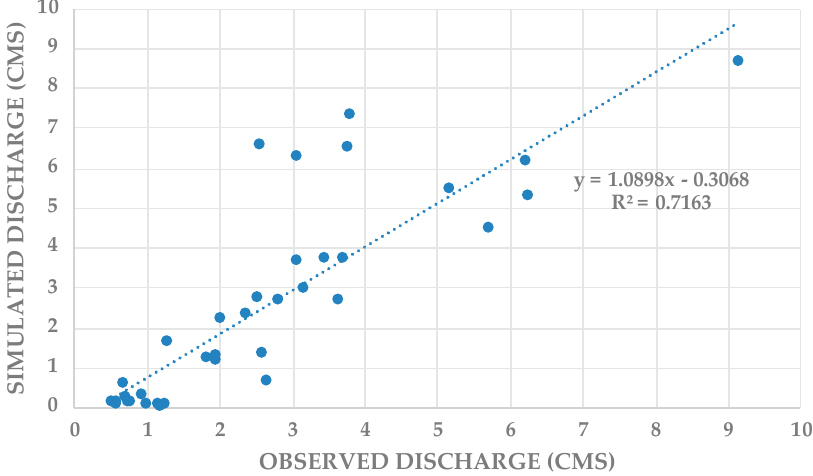
Figure 9. Monthly (2010–2012) simulated and observed stream discharge in the Guanajibo Watershed: observed vs. GOES-PRWEB-estimated RO + DP.